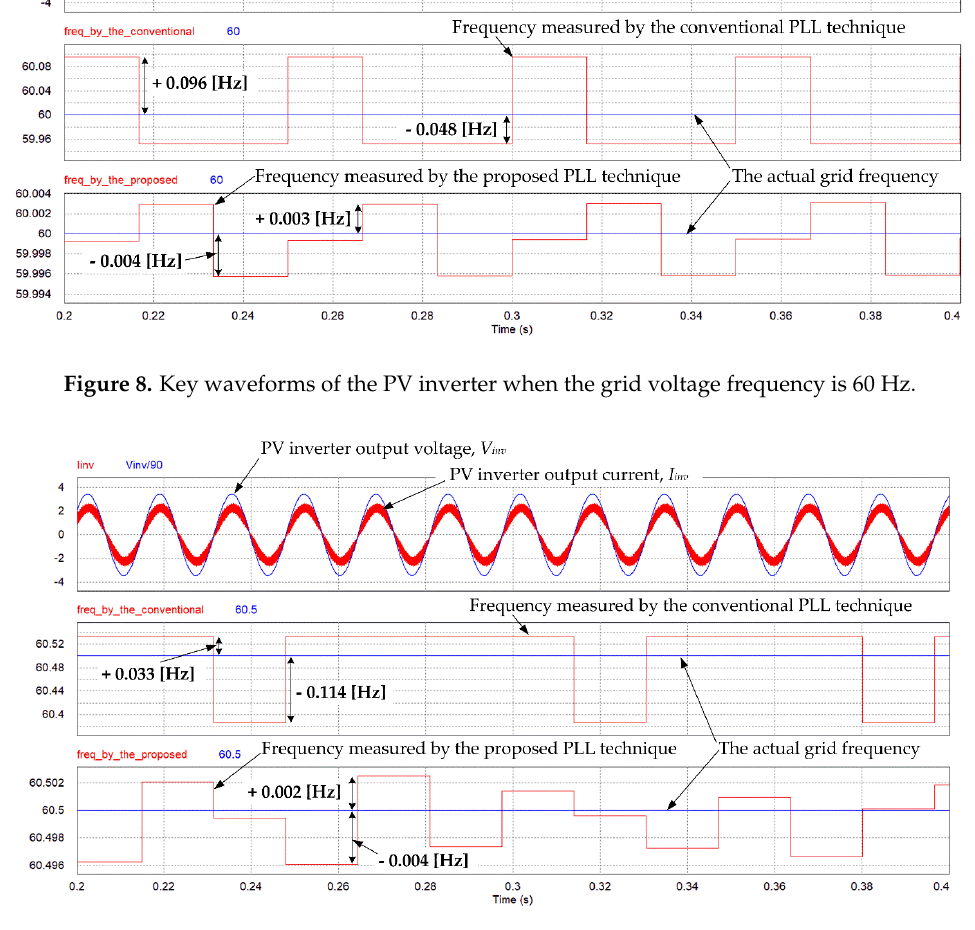
Figure 9. Key waveforms of the PV inverter when the grid voltage frequency is 60.5 Hz.